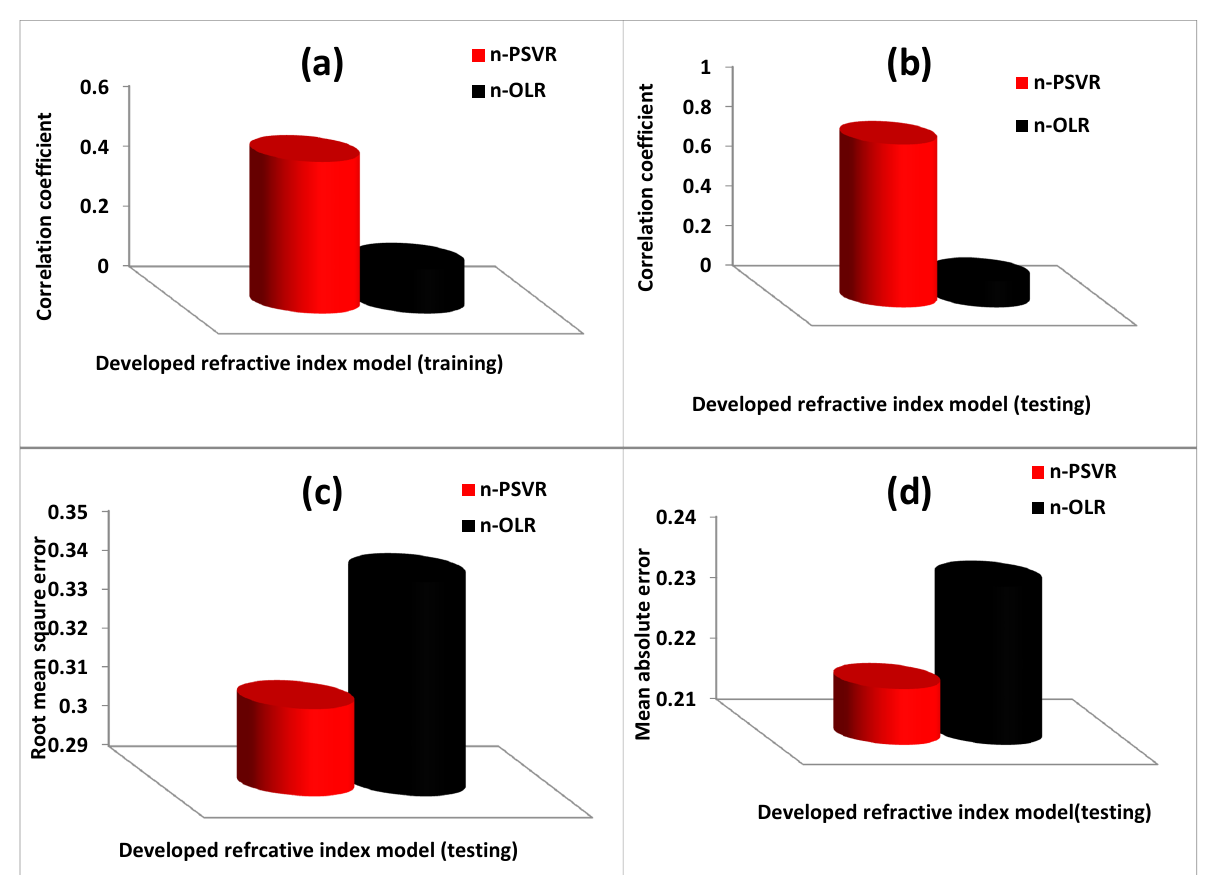
Figure 4. Performance of the developed n-PSVR model using various error metrics. ( a ) Correlation coefficient for each of the developed refractive index model during training phase ( b ) Correlation coefficient for each of the developed refractive index model during testing phase ( c ) Root mean square error for each of the developed refractive index model during training phase ( d ) Mean absolute error for each of the developed refractive index model during testing phase.